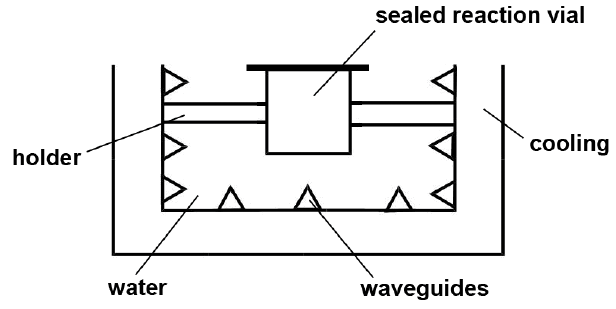
Figure 9. Principal scheme of experimental setup.